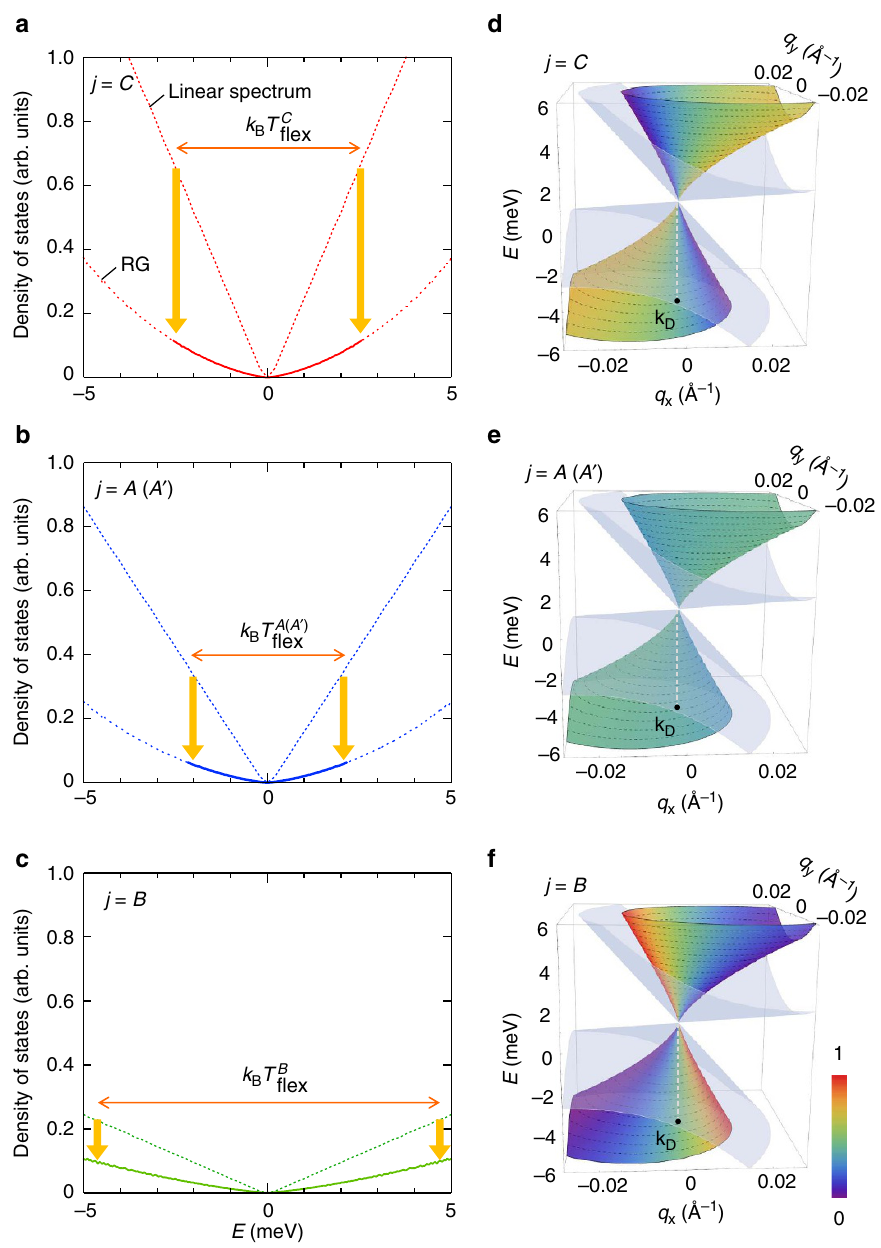
Figure 4 | LR Coulomb-induced titled Dirac cone reshaping. ( a – c ) The calculated DOS near the gapless point (at E ¼ E F ¼ 0) plotted as a function of energy E for the non-equivalent site j ¼ C ( a ), A ( ¼ A ’) ( b ) and B ( c ) in the unit cell. The thin dotted and thick dashed curves are the DOS profiles for the linear spectrum and the RG-corrected DOS, respectively, calculated for the momentum cutoff L ¼ 0.667Å (cid:2) 1 and optimum fitting parameters ( u , e ) ¼ (0.35, 1). Note that the bandwidth reduction effect, associated with u ¼ 0.35 ( o 1), is taken into account in both curves. The thick bold parts in the RG-corrected DOS, highlighted around the gapless point, correspond to the energy range ( D E j (cid:3) k B T j ) where the T -driven RG flow is visible in the flex experiment (also indicated by the horizontal left-right arrows). Vertical thick bold arrows represent the suppression of the DOS due to the LR Coulomb interaction. ( d – f ) Calculations of the reshaped tilted Dirac cone (around k D ) induced by the RG flow of the velocities, derived from the same parameters as in a – c . The label bar reflects the site-spectral weight n z q ð Þ around the cone for the non-equivalent site j ¼ C ( d ), A ( ¼ A ’) ( e ) and B ( f ) in the unit cell j plotted as a function of the wave vector q ¼ k (cid:2) k D ¼ ( q x , q y ) (in Å (cid:2) 1 ). The outer grey cone stands for the linear spectrum in the absence of the LR Coulomb interaction, where the bandwidth reduction effect is considered (corresponding to the E -linear DOS in a – c ). (See Methods for